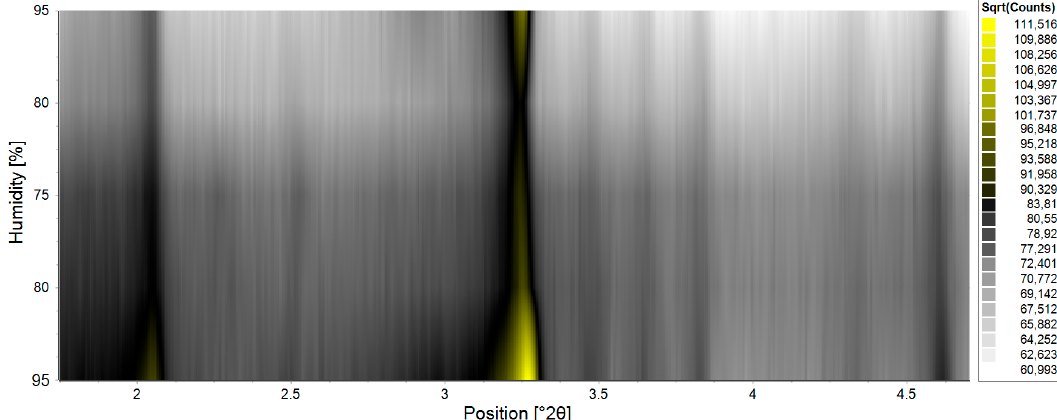
Figure 17. Surface plot of XRPD data of HEWL polycrystalline precipitates in a complete de/rehydration process (95 → 80 → 75 → 80 → 95% rH). Samples were crystallized at pH 4.5.